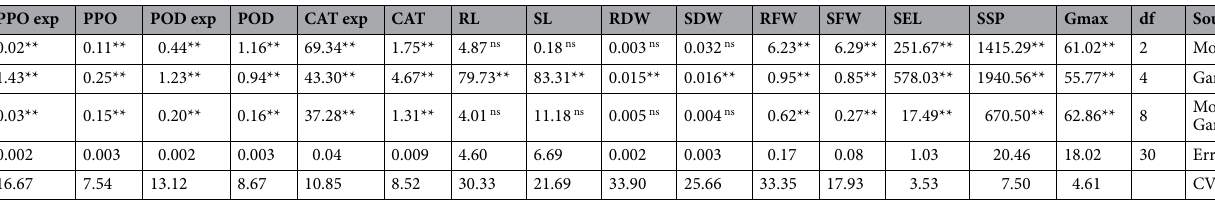
Table 1. Analysis of variance of the effect of gamma irradiation and different seed moisture contents on some morphological, biochemical and molecular aspects of bread wheat. Gmax maximum germination percent, SSP seedling survival percent, SEL seedling length, SFW stem fresh weight, RFW root fresh weight, SDW stem dry weight, RDW root dry weight, SL stem length, RL root length, CAT catalase activity, CAT exp relative expression of catalase gene, POD peroxidase activity, POD exp relative expression of peroxidase gene, PPO polyphenol oxidase activity, PPO exp relative expression of polyphenol oxidase gene, ns non-significant. **,*Significant at 1% and 5% levels of probability, respectively.